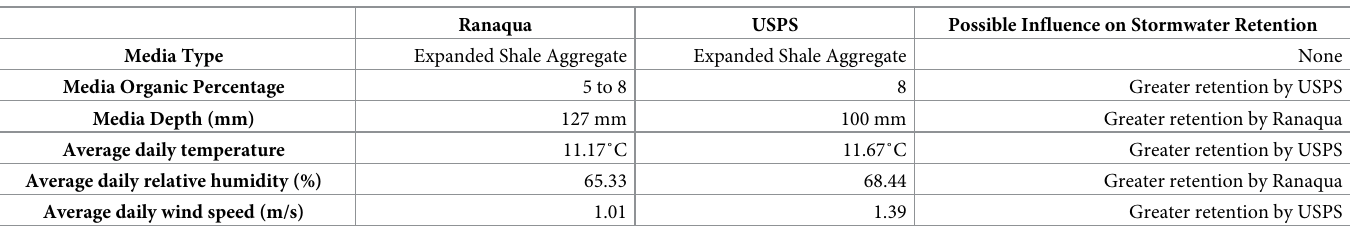
Table 2. Confounding